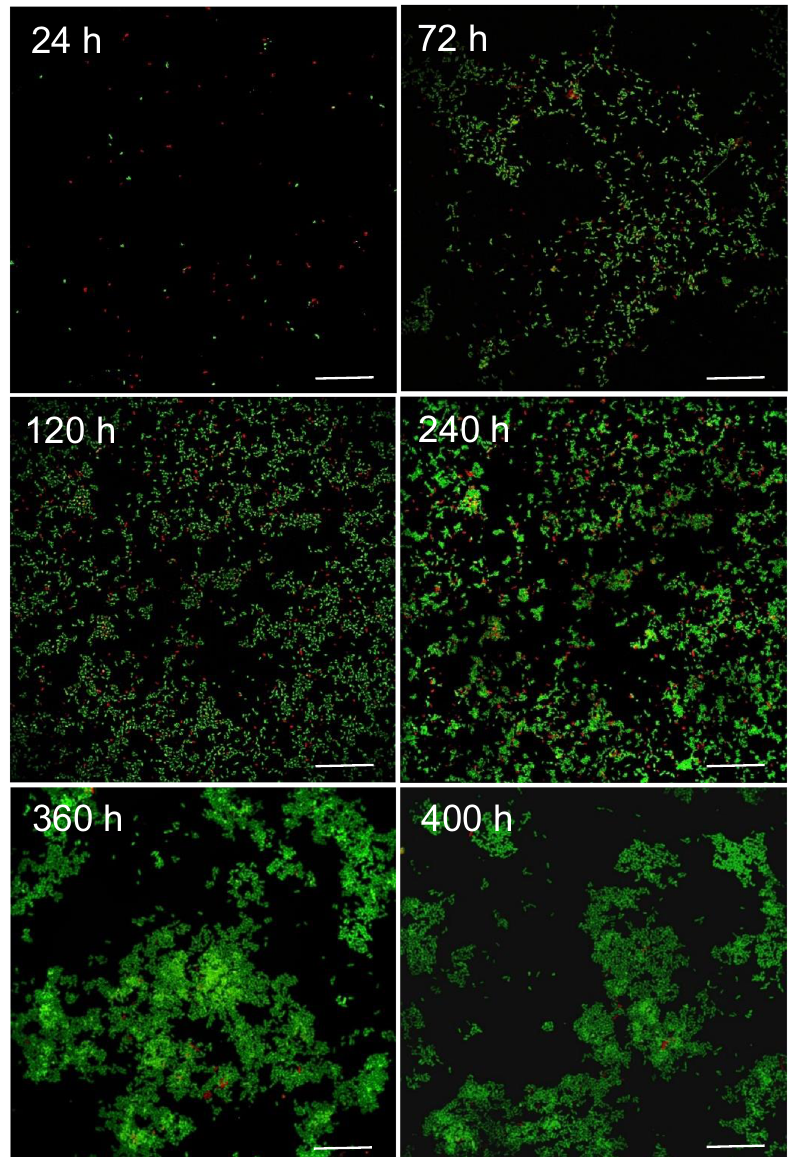
Fig. 4 Representative FISH-CLSM images of D. acetexigens (green) and G. sulfurreducens (red). Cells extracted from the anode bio fi lm of a co-culture MEC reactor fed with synthetic medium containing acetate (MEC co-culture-NaAc-N2 ). Samples for FISH analysis were collected from the anode bio fi lm at different time periods of reactor operation. Scale bar for all images is 25